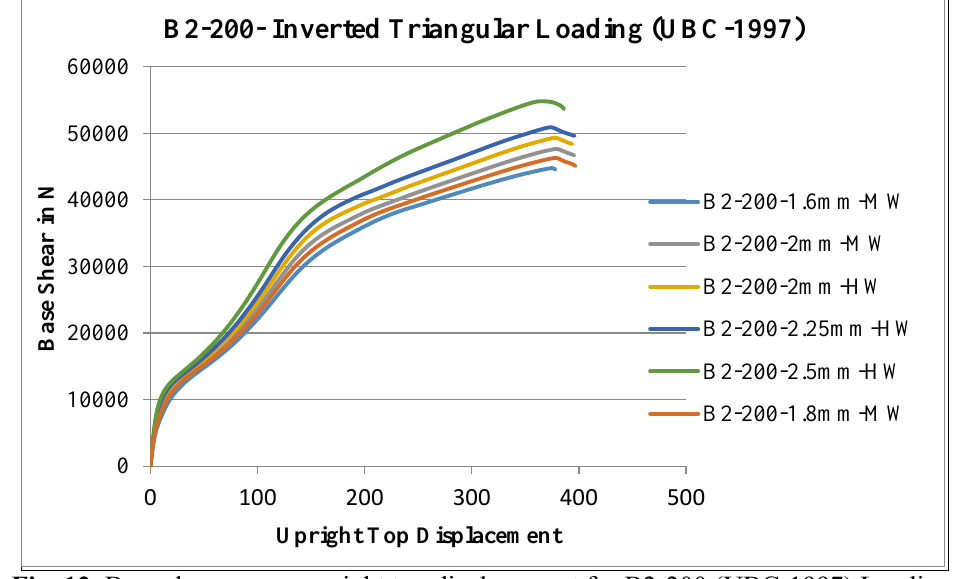
Fig. 12. Base shear verses upright top displacement for B2-200 (UBC-1997) Loading.